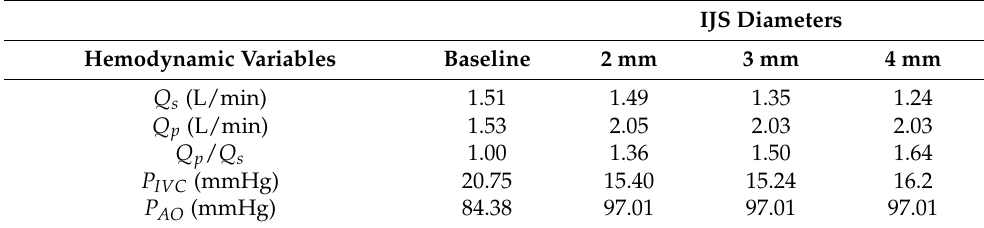
Table 3. Pressure and flow measurement for baseline and various IJS diameters.